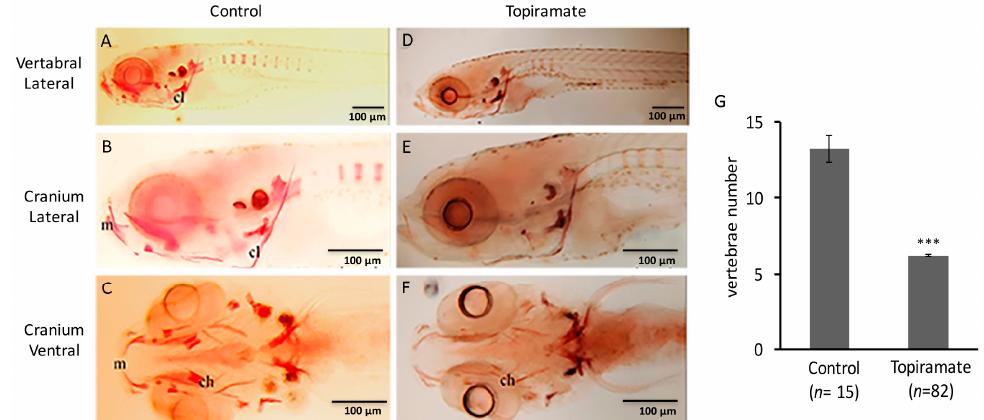
Figure 4. Bone development of offspring was impaired through maternal transmission of